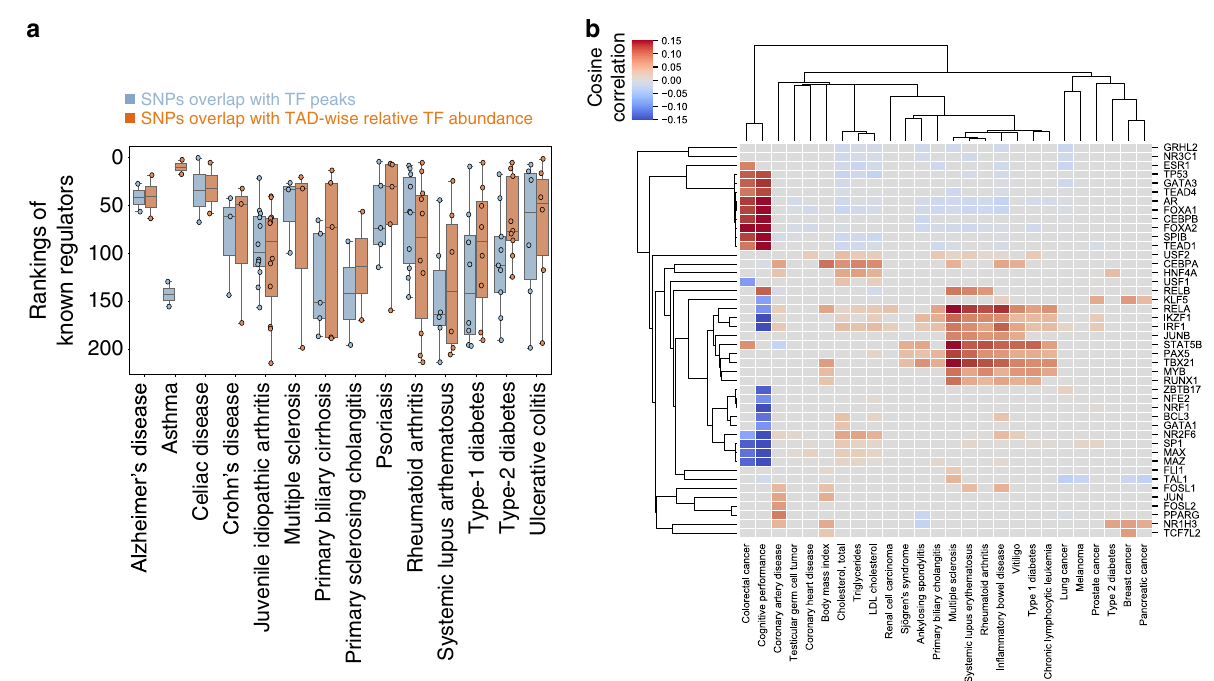
Fig. 6 TAD-wise analysis of non-coding GWAS hits prioritizes relevant TFs. a Evaluation of the inference of GWAS-SNP relevant TFs on the basis of rankings of known disease-associated TFs. Blue boxes are known disease-associated TFs ranked by overlapping SNPs with TF ChIP-seq peaks, whereas orange boxes are known disease-associated TFs ranked by overlapping SNPs with TADs characterized by different relative TAD-wise TF abundances. The later approach can be approximated as cosine similarities between relative TAD-wise TF occupancies and numbers of disease-associated SNPs in TADs. The two-sided Wilcoxon signed-rank test p value of the paired median TF rankings is 0.005 ( n = 14). The box plot extends from the lower to the upper quartile values of the data, with a line at the median. The whiskers extend from the box to show the range of the data. b The heatmap shows the long-range TFs implicated from GWAS SNPs. The x axis represents traits in the GWAS Catalog, especially autoimmune disease, cancers, and metabolic syndromes, and the y axis are inferred long-range TFs. Each entry is the color-coded cosine similarity between relative TF occupancies in TADs and numbers of trait- associated SNPs in TADs. Red squares or blue squares are trait-TF pairs with signi fi cantly ( p value < 0.001 using one-sided permutation considering multiple hypothesis test) positive or negative cosine similarities, respectively. TFs and traits were clustered using hierarchical clustering. Source data are provided as a Source Data fi